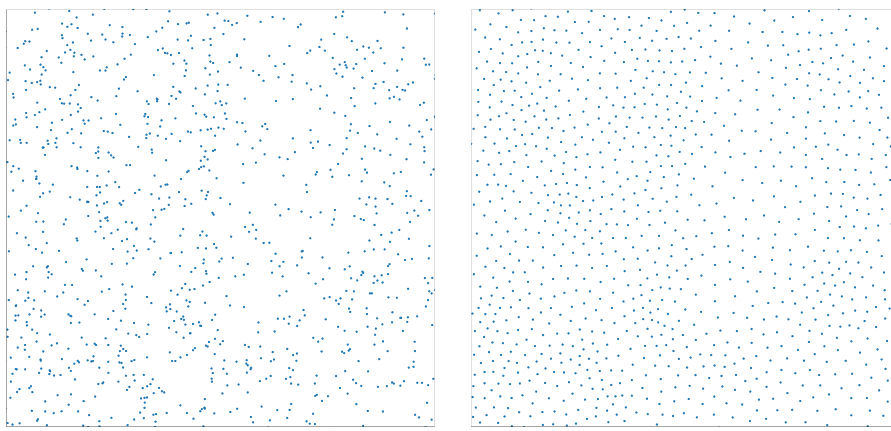
Figure 21 . The point data for the straight line boundary example considered in section 7.1.2. The left panel shows the original N = 1000 points distributed according to (2.5) with ρ = 1 . 5 . The right panel shows the same data after applying 5 Lloyd